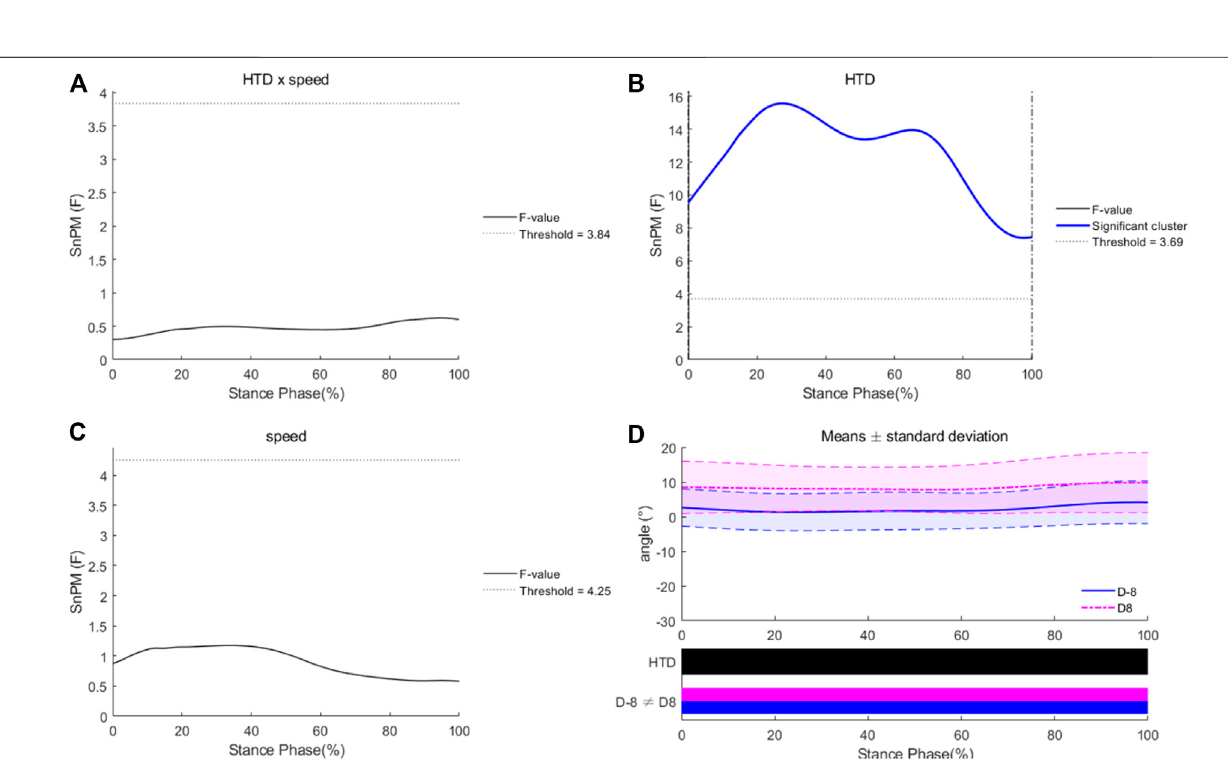
Frontiers in Bioengineering and Biotechnology |